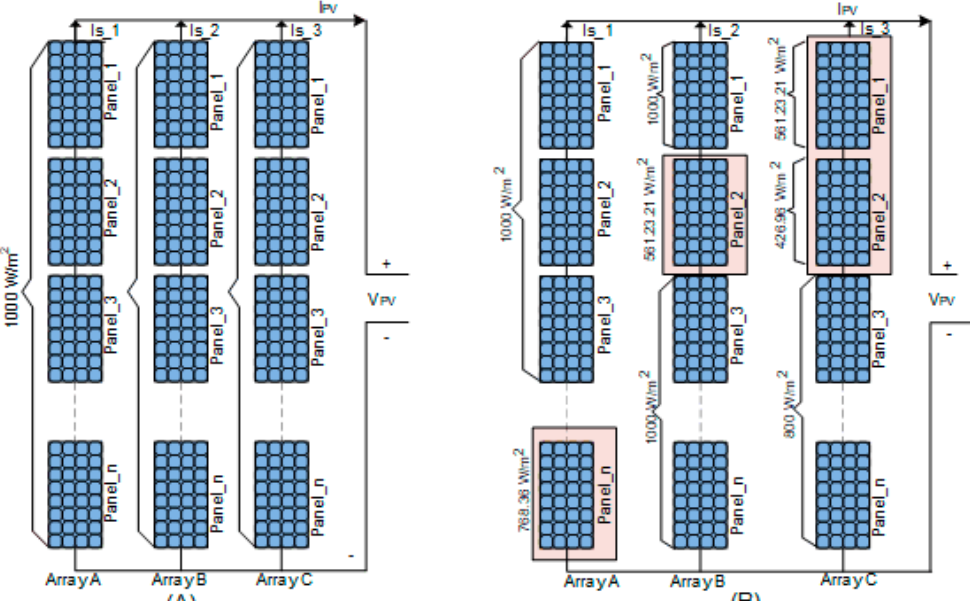
Figure 3. Solar photovoltaic system with uniform ( A ) and non-uniform ( B ) solar irradiance conditions.